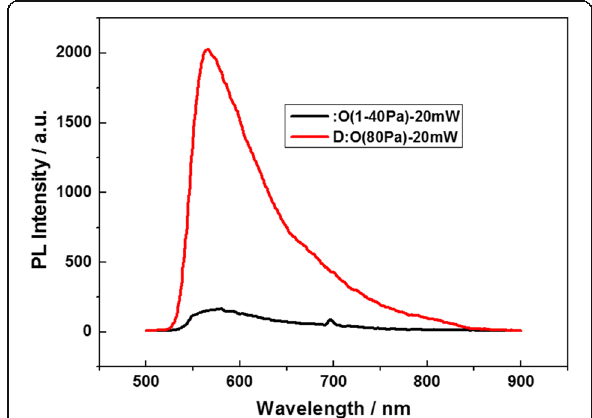
Fig. 3 PL spectra near 560 nm measured at room temperature made a comparison between the sample I ( black curve ) and the sample II ( red curve )